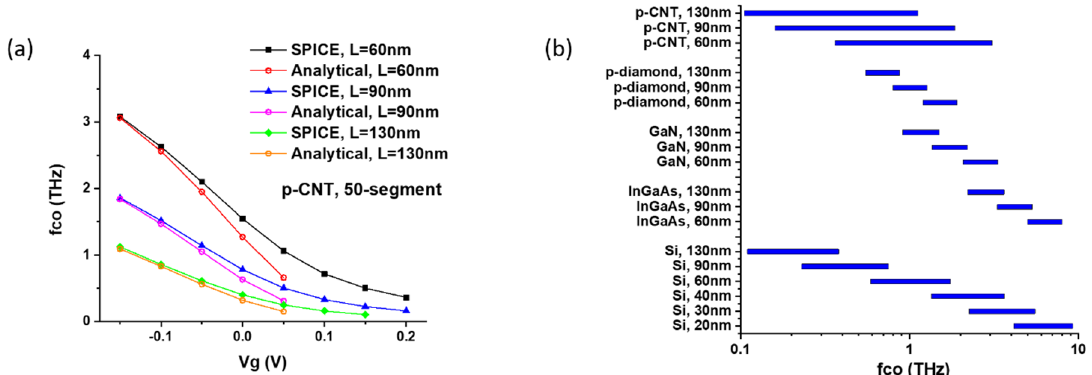
Figure 7. ( a ) Gate-voltage dependent cross-over frequencies estimated from the simulated results and analytical model with different channel lengths of the p-CNTFET. ( b ) Cross-over frequency ranges in different material-based devices [26].